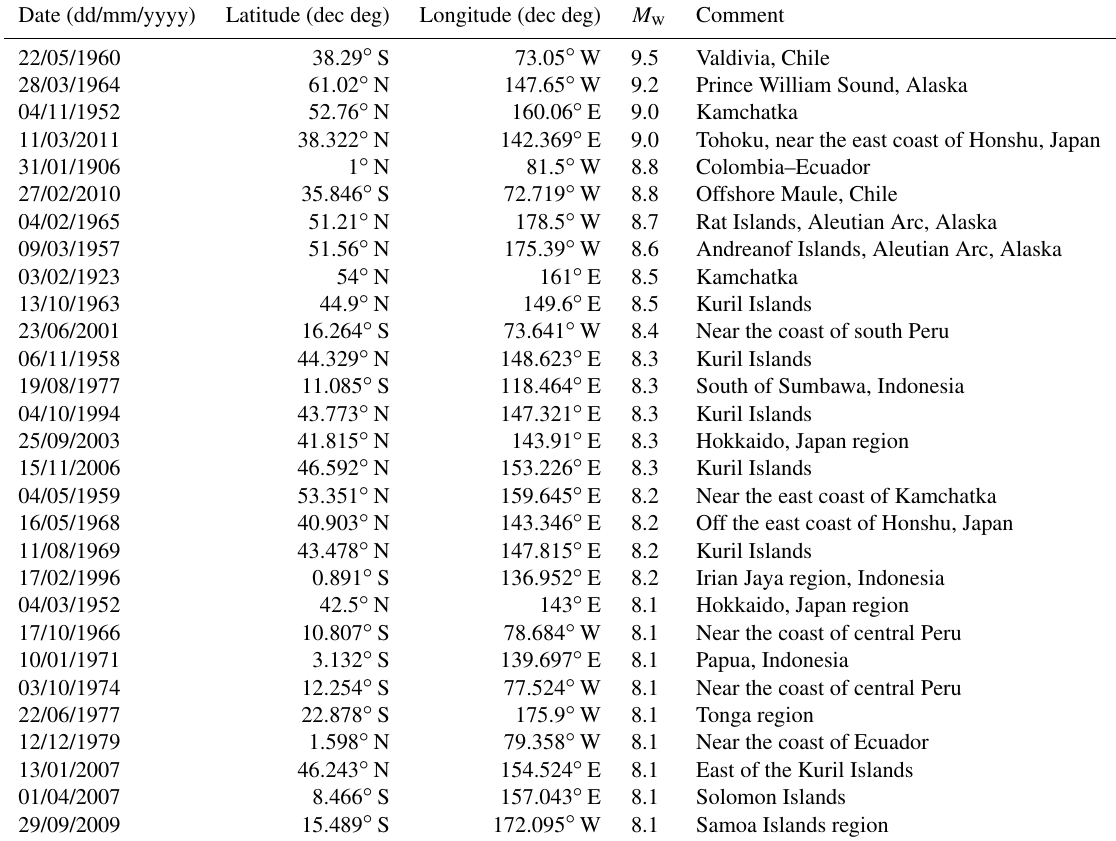
Table 1. Largest Pacific earthquakes and the approximate location of their epicentres since 1900 and Pacific earthquakes of M w ≥ 8.1 since 1950 (in order of decreasing magnitude). Data from USGS (see